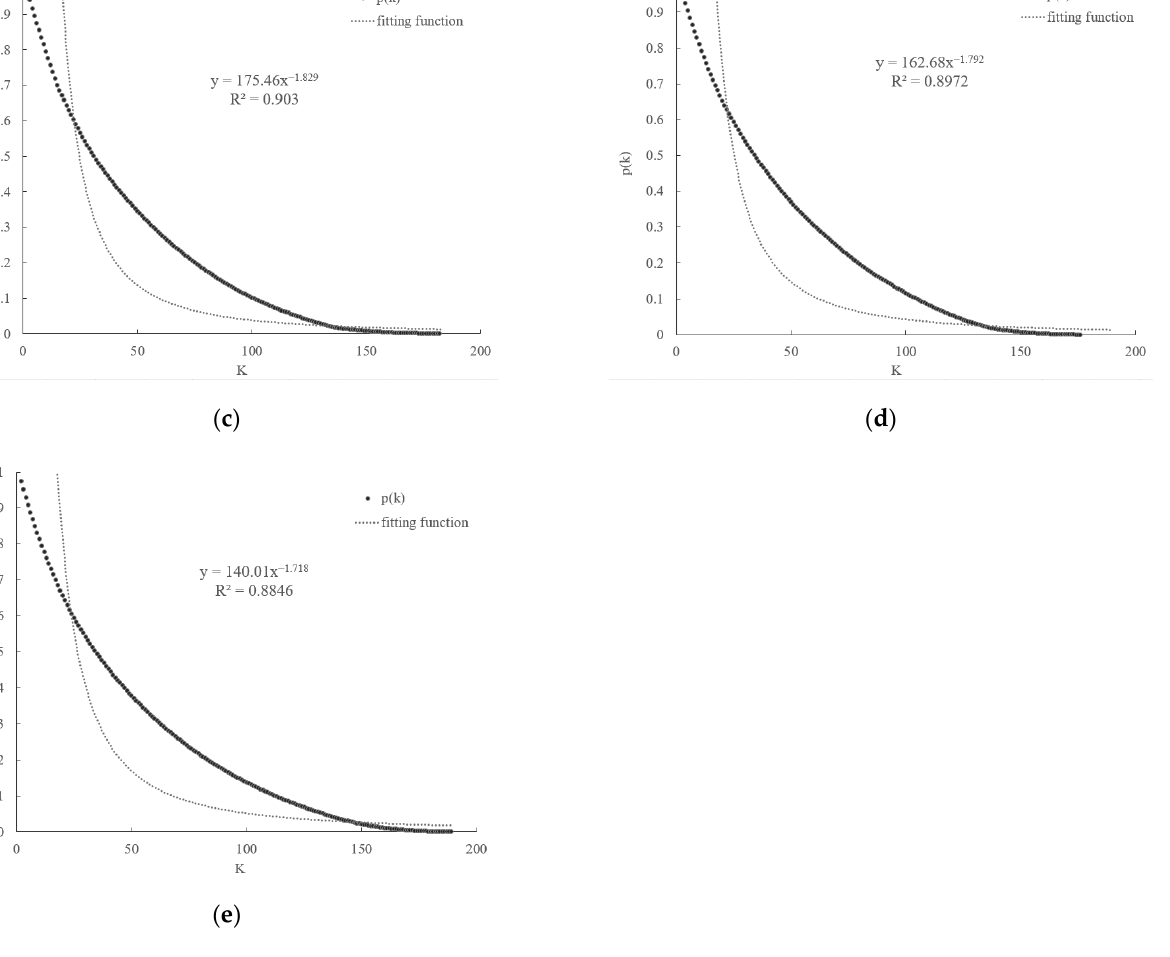
Figure 3. The accumulative distribution of the global FTN . The distribution curves for different years are as follows: ( a ) in 1994; ( b ) in 2000; ( c ) in 2006; ( d ) in 2012; and ( e ) in 2018. X represents the degree of node ( k ) in the global FTN . Y represents the value of the power law index in degrees. R 2 expresses the explanatory degree of the relationship between the x and y variables. The values of R 2 range from 0 to 1. The higher the value, the closer relationship between the x and y variables.